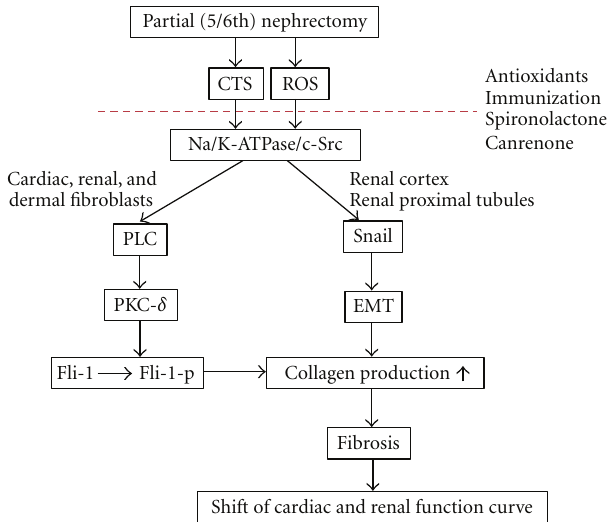
Figure 1: Schematic illustration of the e ff ect of CTS on fibrosis.